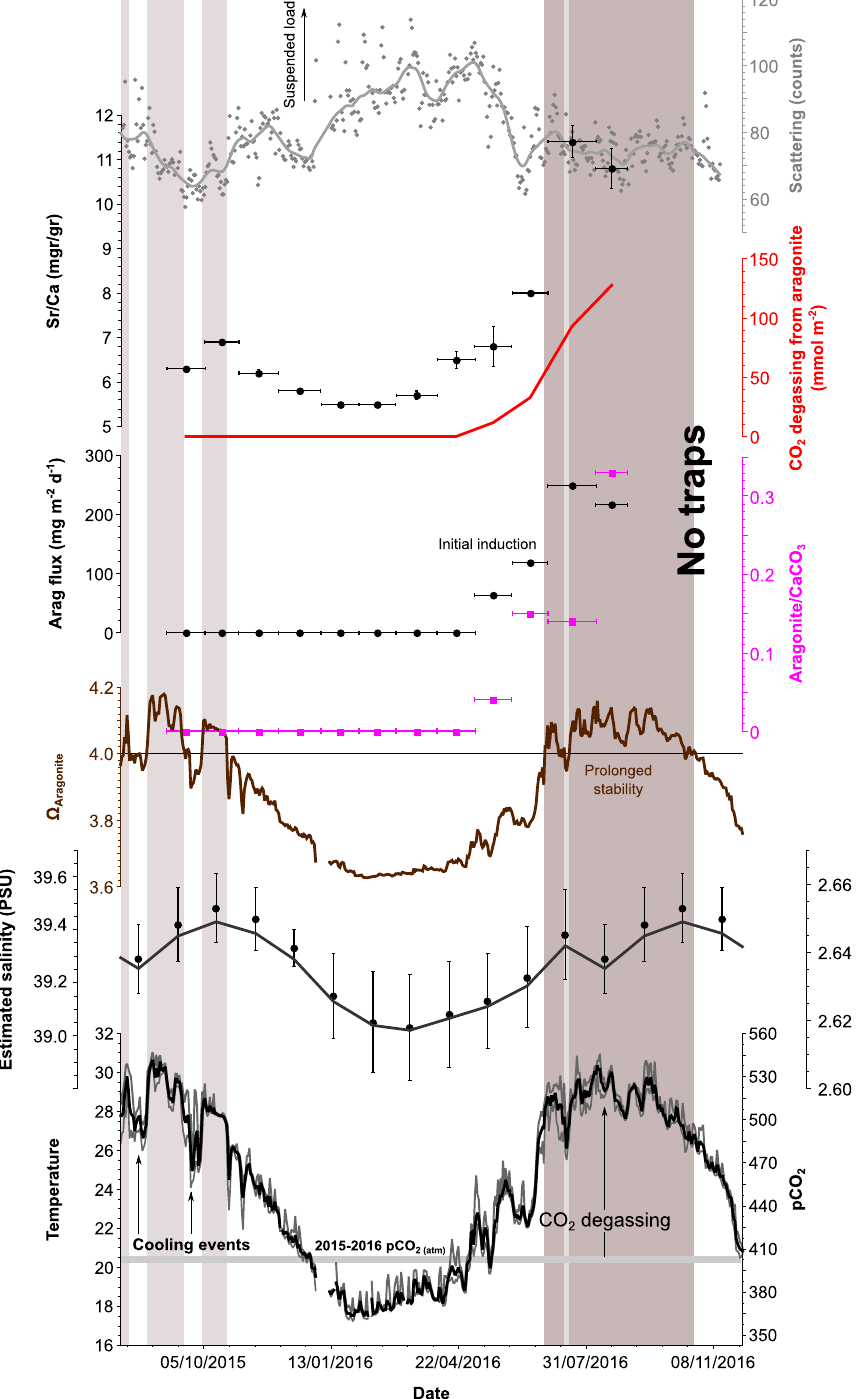
Figure 2. Record from the Hadera station showing (from the bottom), temperature (at 26 m) and inferred pCO 2 , mean monthly salinity for the given month and inferred alkalinity, calculated saturation index for aragonite, aragonite fraction of total carbonate, flux of aragonite to the trap, inferred total CO 2 degassing from aragonite precipitation, Sr/Ca ratio of the sediment in the trap, and acoustic backscatter. Shaded areas indicate periods when seawater Ω Ar > 4 (see Fig.